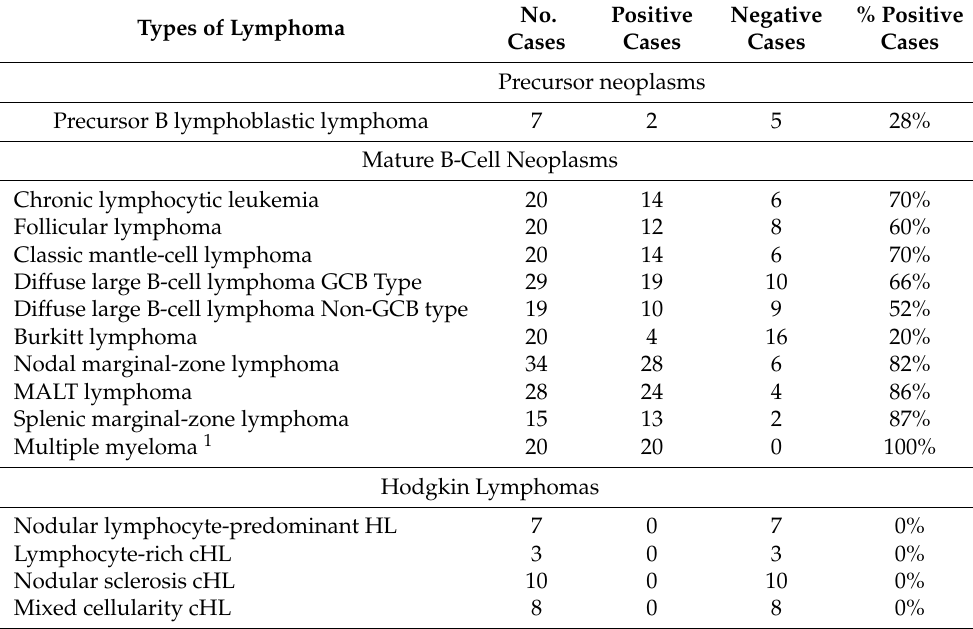
Table 1. CD229 expression in lymphomas and myeloma. Types of